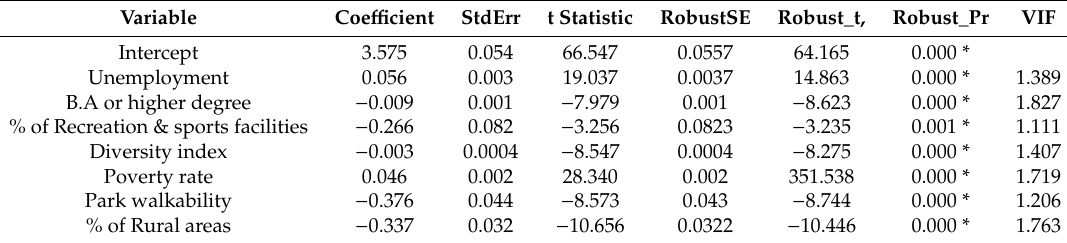
Table 2. Results of the generalized linear model